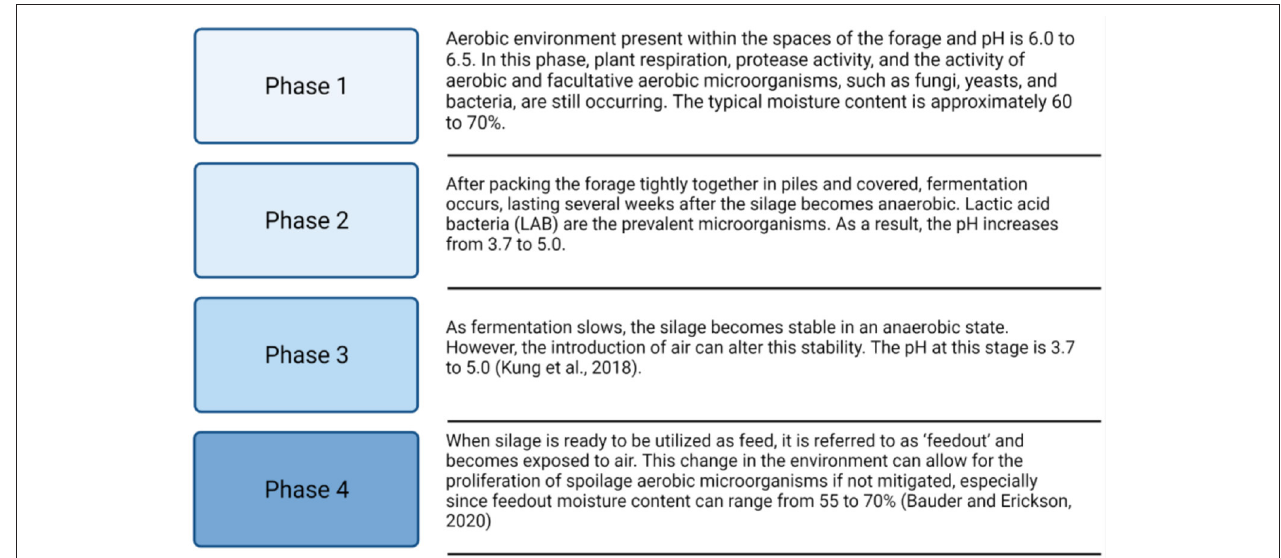
FIGURE 2 | The phases of ensiling. Adapted from Weinberg and Muck (1996). The general four phases in the standard ensiling process of forages to silage. Created with Biorender.com.